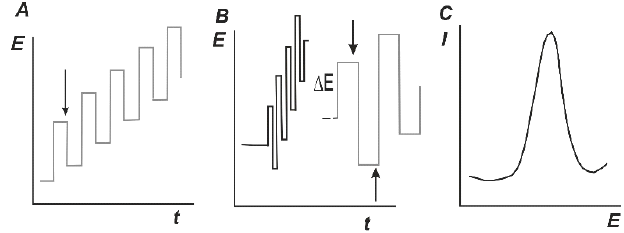
Figure 8. Differential pulse voltammetry (DPV) ( A ) and square-wave voltammetry (SWV) ( B ) and signal shape ( C ). Arrows mark sampling points.